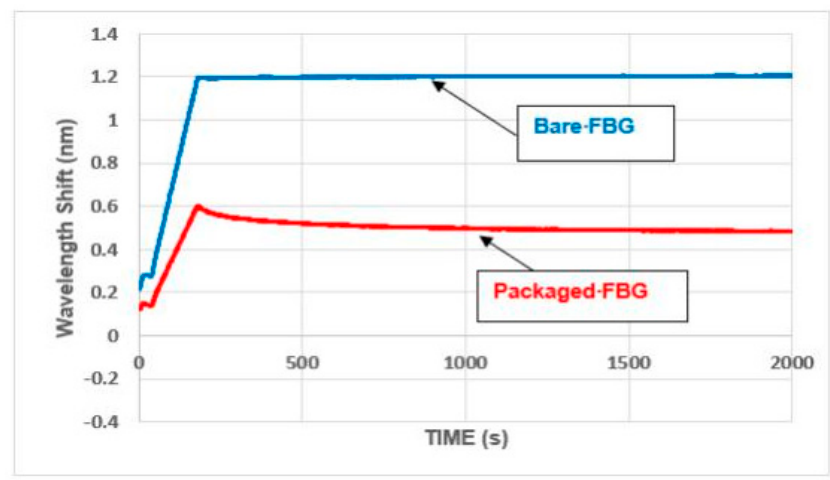
Figure 16. Closed top package: creep behavior at 5.0 kN (total load).